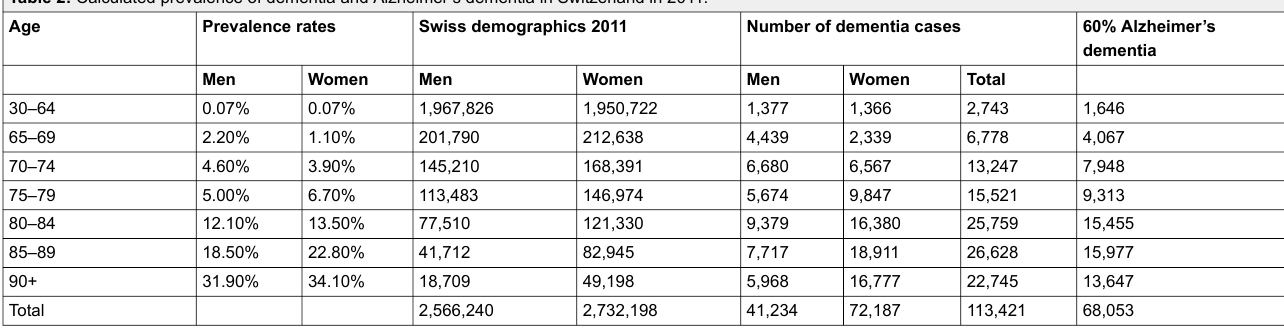
Table 2: Calculated prevalence of dementia and Alzheimer’s dementia in Switzerland in 2011.